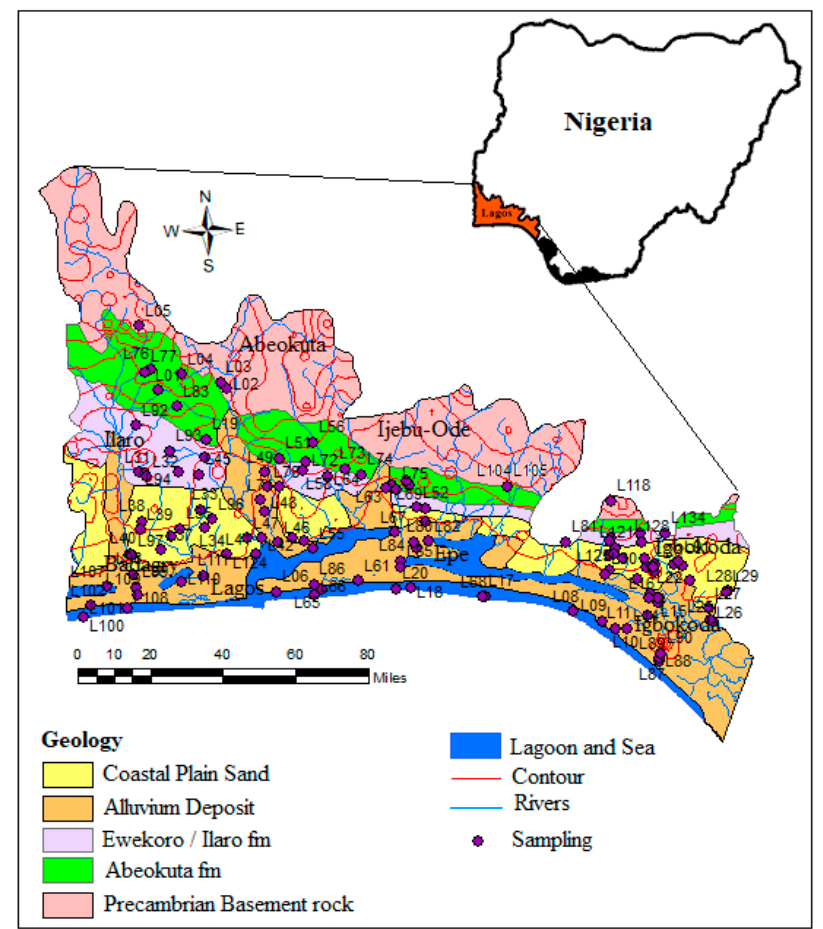
Figure 2. Geology map of the Eastern Dahomey basin showing the sampling points.